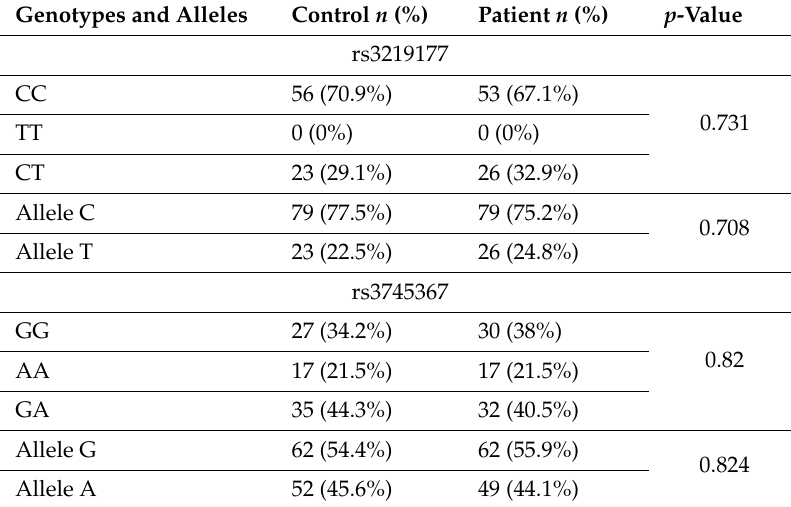
Table 5. Frequencies of RETN genotypes and alleles in